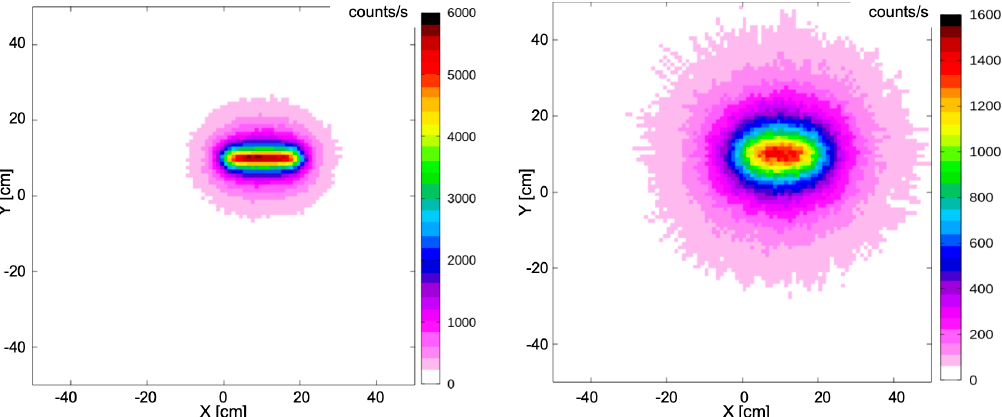
Figure 14. Hot-spot images of a 1 MBq 137 Cs gamma source, uniformly distributed over a sheet measuring 2.5 × 20 cm 2 placed at 1 cm (left) and a 5 cm (right) distances, obtained by simulating a table with 100 × 100 CsI(Tl) scintillators measuring 1 cm 3 .